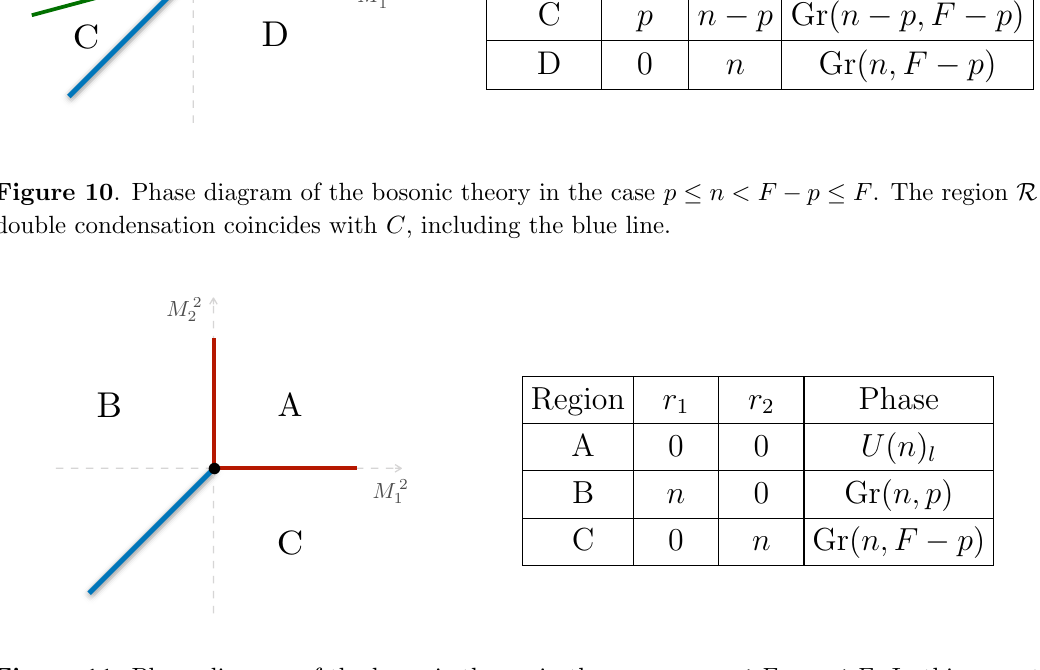
F p F . In this case, the ≤ − ≤